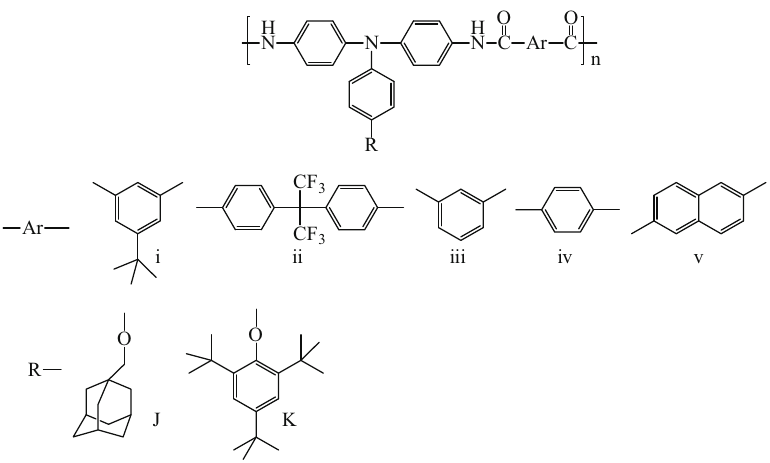
Figure 14: Structure of the PAs synthesized from TPA containing bulky pendant groups ( 92,93 )